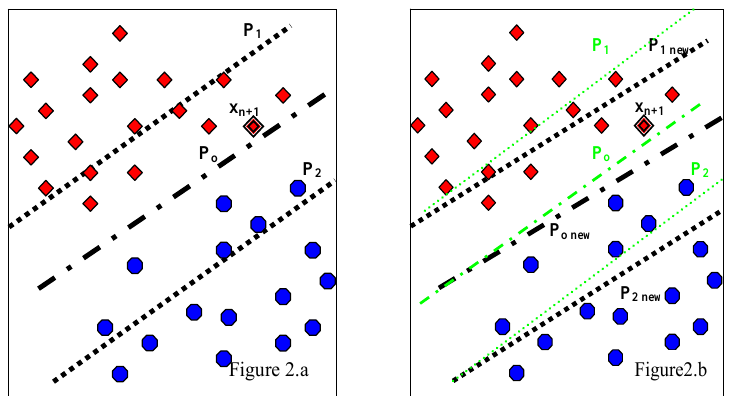
on plane orientation when model is updated. Figure 2 . Effect of x N+1